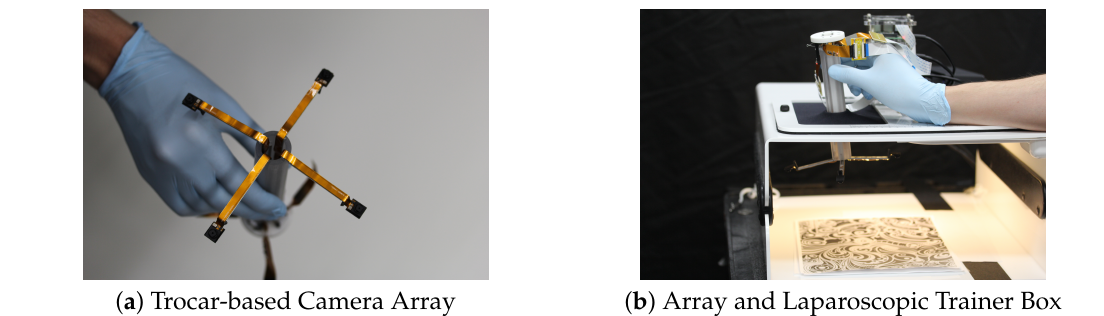
Figure 1. The trocar-based camera array offers improved FoV over traditional laparoscopes by utilizing multiple visual sensors. The extra field of view can encompass significantly more of the surgical area so that the surgeon does not have to spend as much effort adjusting camera location while performing surgical